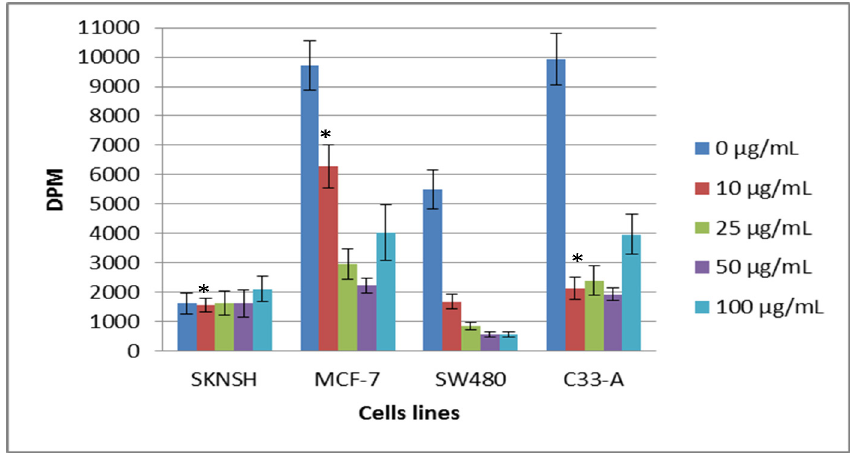
Figure 7. Effect of lectin on cell proliferation 48 h after the lectins were removed from the cells, employing the 3 [H]-thymidine assay. Cells were previously incubated for 24 h with the lectin solutions; then, the solutions were removed and the cells were incubated for only 48 h with the culture cell solutions [Dulbecco’s modified Eagle’s medium (DMEM) and fetal bovine serum (FBS)]. All values are expressed as mean ± SEM of three independent